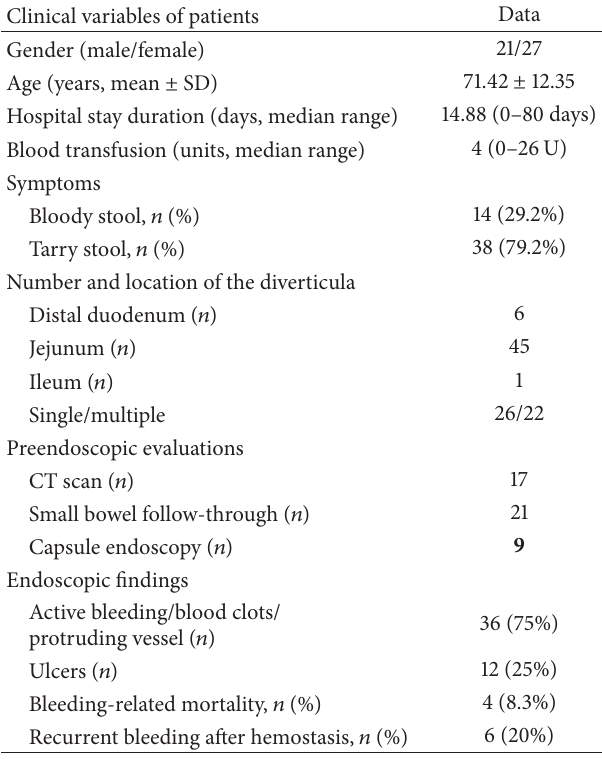
Table 1: Demographic data and clinical features of patients with small bowel diverticular hemorrhage ( 𝑛 = 48 ).